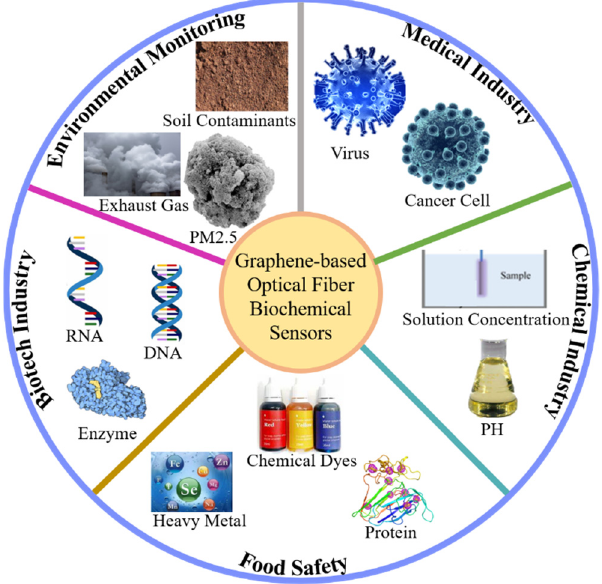
Figure 4. Diagrams of biochemical sensors for detecting important substances in different fields.